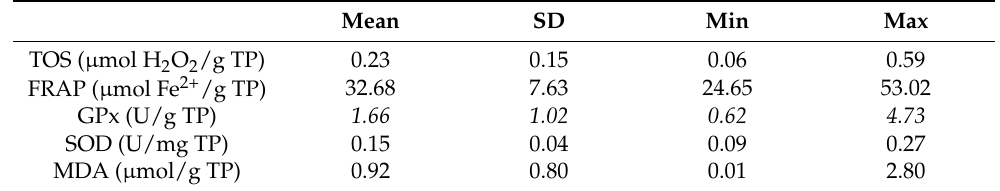
Table 3. Markers of oxidative stress in bovine seminal plasma.